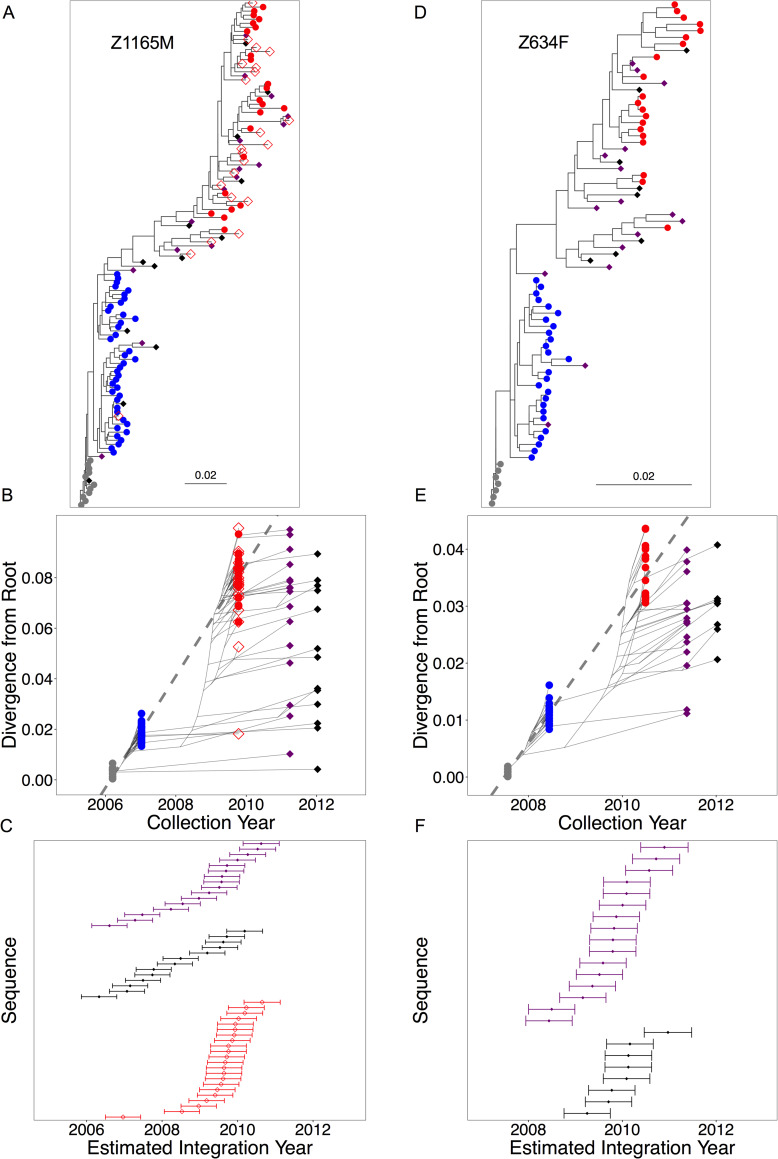
Regression-based inference of time of provirus integration.Representative figures for participant Z1165M (A-C) and participant Z634F (D-F). Maximum-likelihood trees of the env gene for pre-therapy variants (circles), including individual seroconversion variants (grey), one year sequences (blue), last pre-therapy sequences (red circles, plasma and open red diamonds, cells), and proviral variants (filled diamonds) in A and D. Two samples during treatment were assessed for both participants, with the first in purple, and subsequent in black. Trees were rooted to optimize the correlation between root-to-tip distance and sampling time for all pre-therapy plasma variants. The linear model relating root-to-tip distances to sampling time is shown in the dashed lines of figures B and E, with the pre-therapy variants denoted as colored dots, and the phylogenetic relationships between them denoted as faint grey lines. Proviral variants from samples collected during treatment are shown in filled diamonds in the same manner. The estimated integration dates of the proviral variants and 95% confidence intervals are shown in the plots C and F. Figures for additional individuals are in S5 Fig.